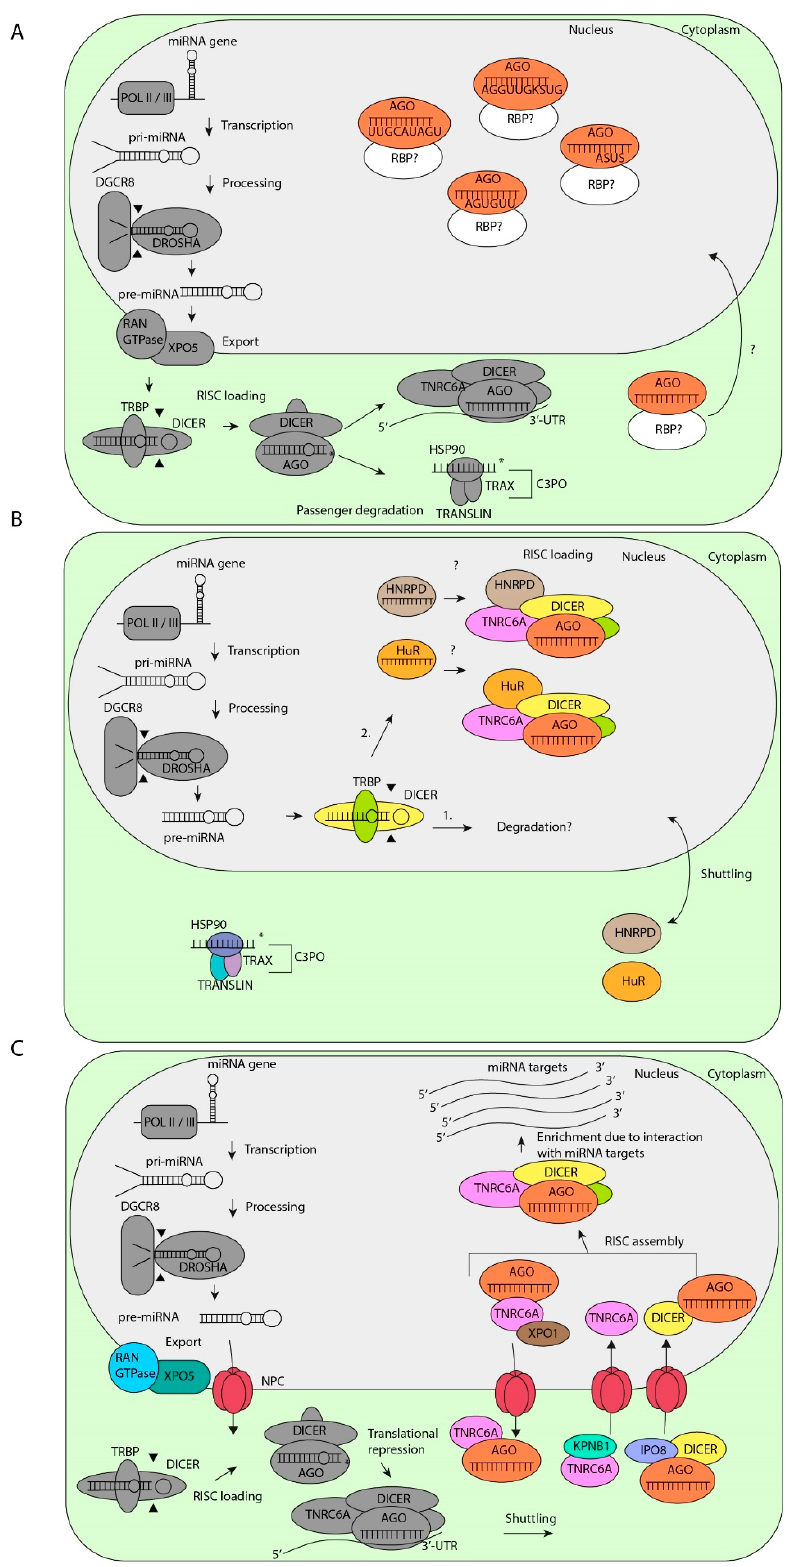
Figure 2. Nuclear localization mechanisms of miRNAs. ( A ) After canonical processing of pri-miRNAs, miRNAs containing specific motifs are transported back into the nucleus by still unknown RNA-binding proteins (RBPs) and mechanisms. ( B ) After processing by DROSHA / DGCR8, pre-miRNAs will be processedbynuclearDICER /